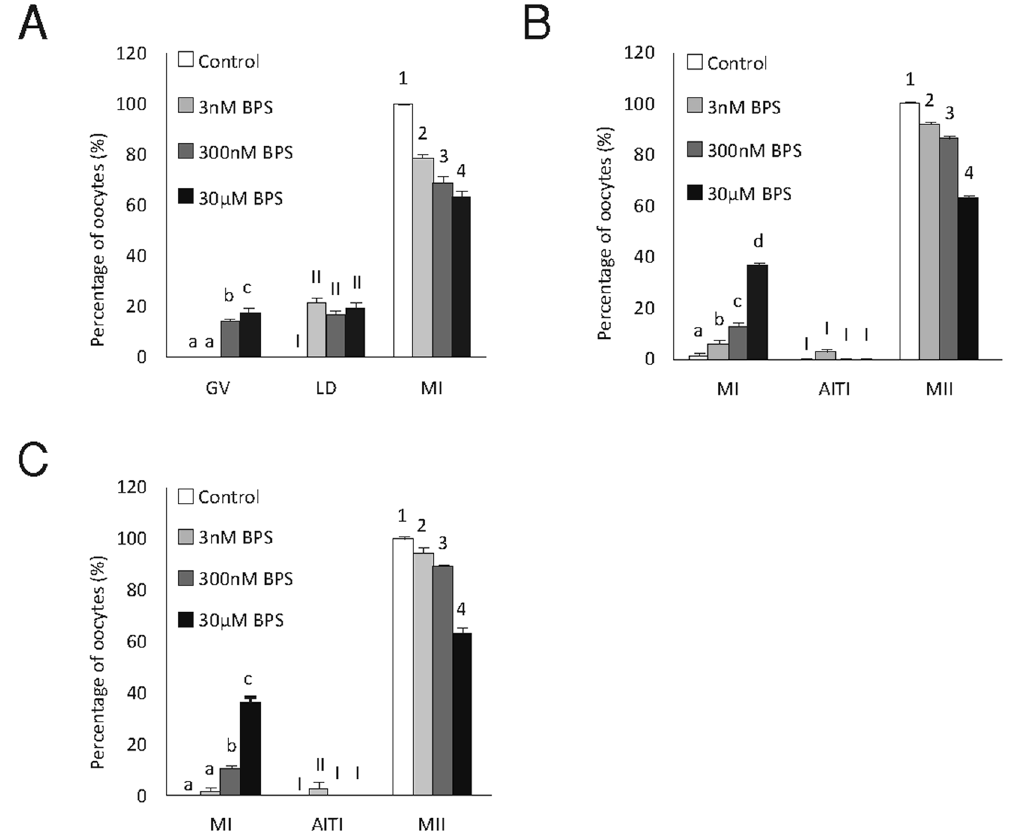
Figure 1. Effects of BPS on the meiotic maturation of oocytes. Effects of BPS (3 nM, 300 nM, and 30 μ M) on the stages of meiotic maturation achieved by oocytes cultured for ( A ) 24 h, ( B ) 48 h, and ( C ) 72 h in vitro . GV – germinal vesicle, LD – late diakinesis, MI – metaphase I, AITI – anaphase I–telophase I, MII – metaphase II. The data are expressed as the mean ± SEM from four independent experiments, n = 120 oocytes per group. Different superscripts denote the statistical significance among experimental groups within the same stage of meiotic maturation (P <